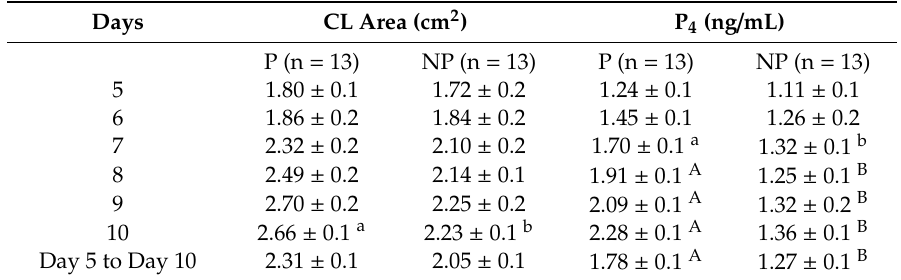
Values are expressed as mean ± standard error. a,b,A,B : For each endpoint, values with di ff erent superscripts within the same row di ff er. a,b : p < 0.05; A,B : p < 0.01.